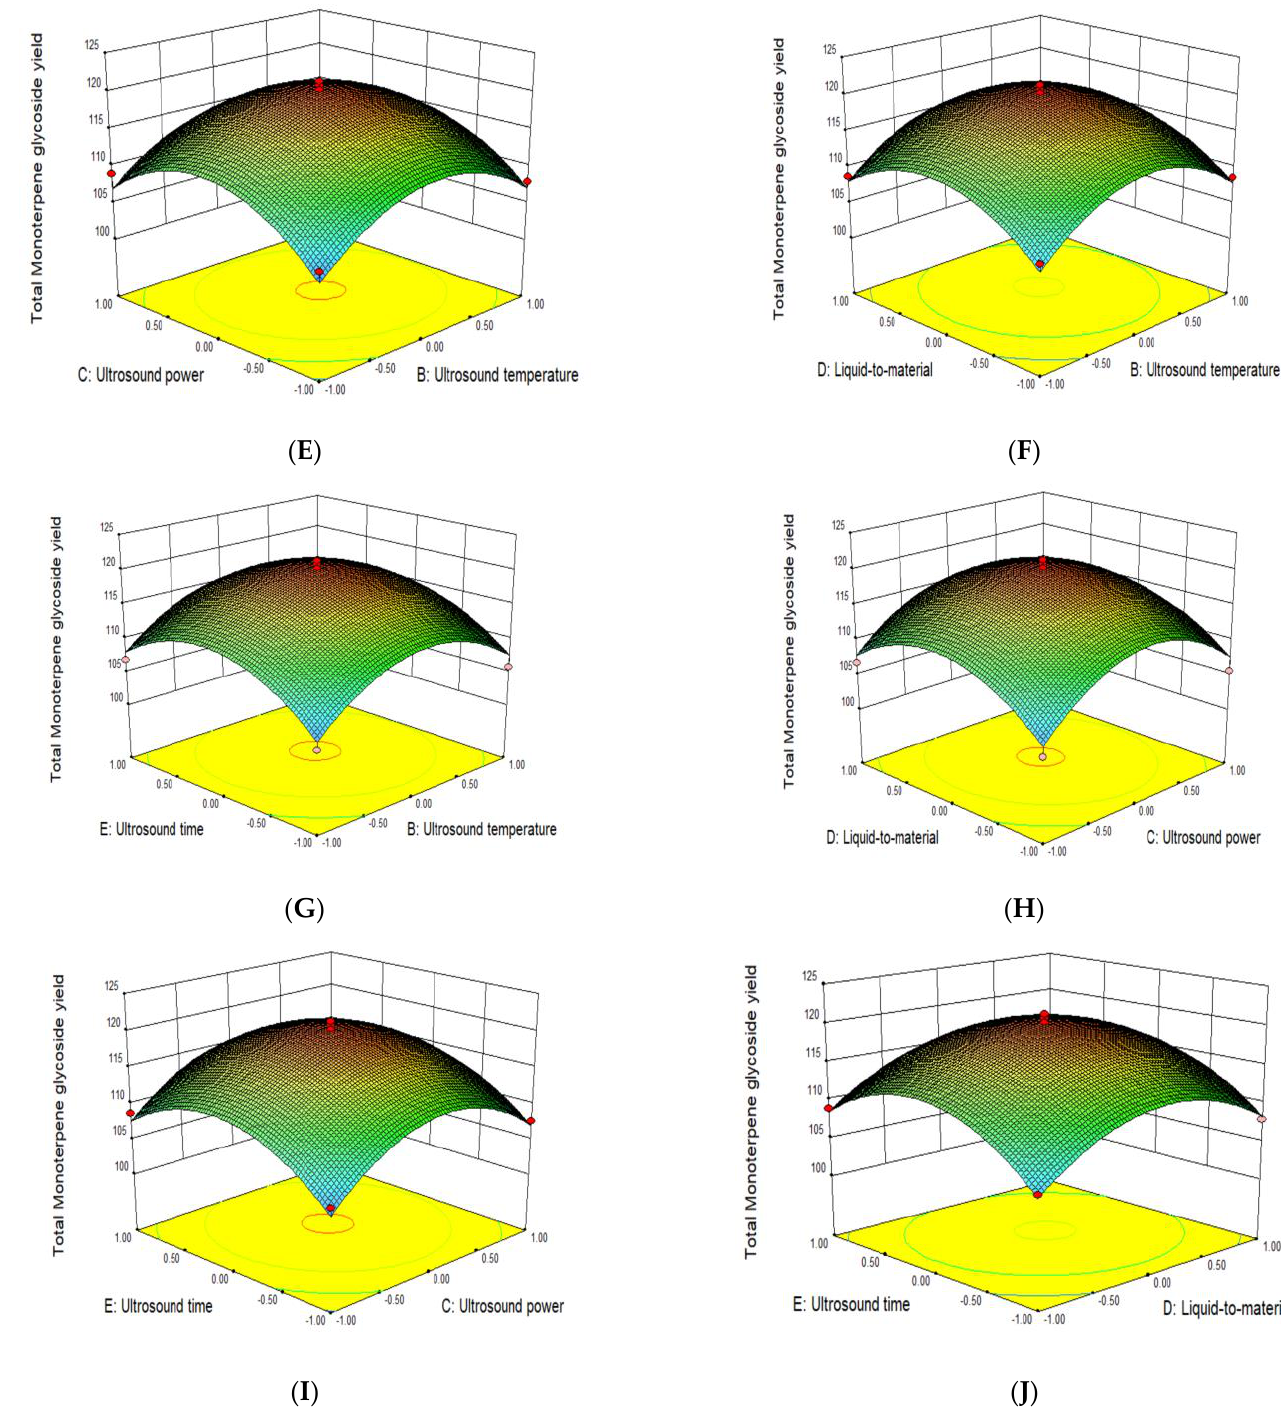
Figure 2. Interaction plots for ethanol concentration and ultrasound temperature ( A ); ethanol con- centration and ultrasound power ( B ); ethanol concentration and liquid–material ratio ( C ); ethanol concentration and ultrasound time ( D ); ultrasound temperature and ultrasound power ( E ); ultra- sound temperature and liquid–material ratio ( F ); ultrasound temperature and ultrasound time ( G ); ultrasound power and liquid–material ratio ( H ); ultrasound power and ultrasound time ( I ); and liquid-to-material ratio and ultrasound time ( J ).